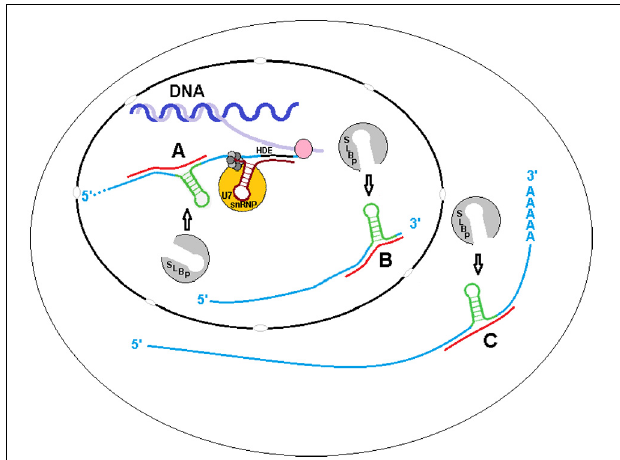
FIGURE 4 | sxRNA in Histone Metabolism. The binding of the Histone Stem Loop (HSL) found at the 3 (cid:2) terminal end of metazoan histone mRNAs by Stem Loop Binding Protein (SLBP) is known to affect their transcription end processing, nuclear export and enhance translation in lieu of a poly(A) tail. Stabilization of the HSL by a ncRNA formed trans 3-way junction may occur during (A) transcription or, as it is believed that SLBP involved in transcription termination does not remain associated with the mRNA (Sullivan et al., 2009) to (B) promote re-association of the message with SLBP for export. After this stage, cytoplasmic histone messages are found trimmed to ∼ 2 bases 3 (cid:2) of the stem, removing the flanking sequence required for 3-way junction formation, with the possible exception of atypical polyadenylated transcripts with internalized HSL motifs. A potential interaction with one of these variants (C) in the cytoplasm is depicted.